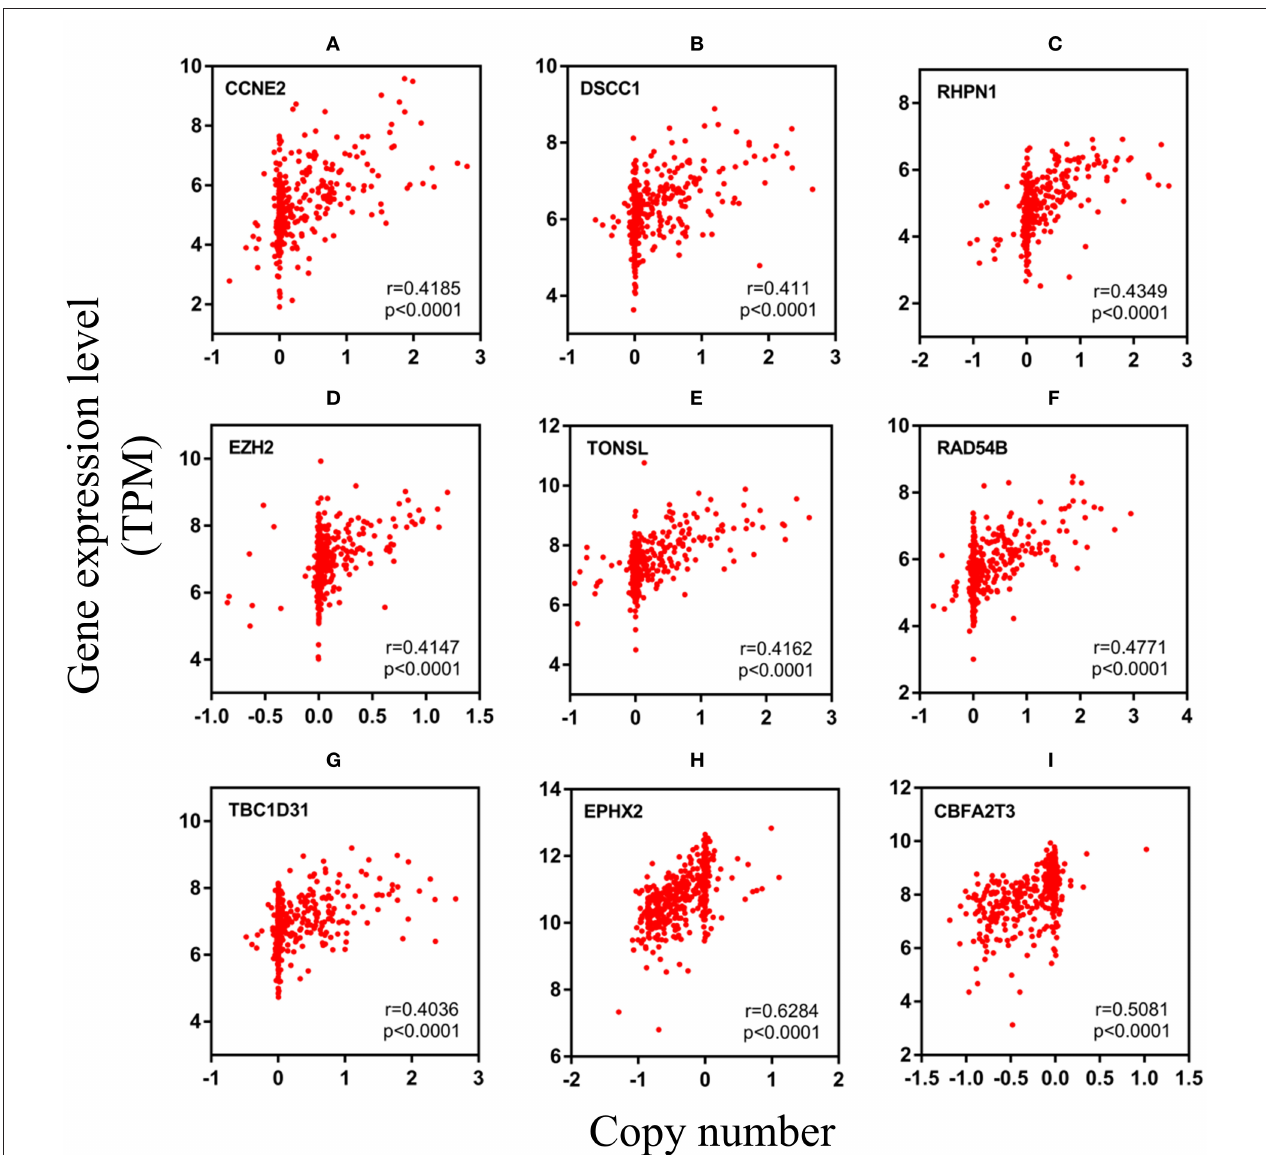
FIGURE 4 | The relevancy of copy number and expression level of nine genes with the Spearman correlation coefficient > 0.4. (A–G) were mainly manifested as an increase in copy number (amplification) and positively correlated with the level of expression. (H,I) were mainly manifested as a loss of copy number (deletion)